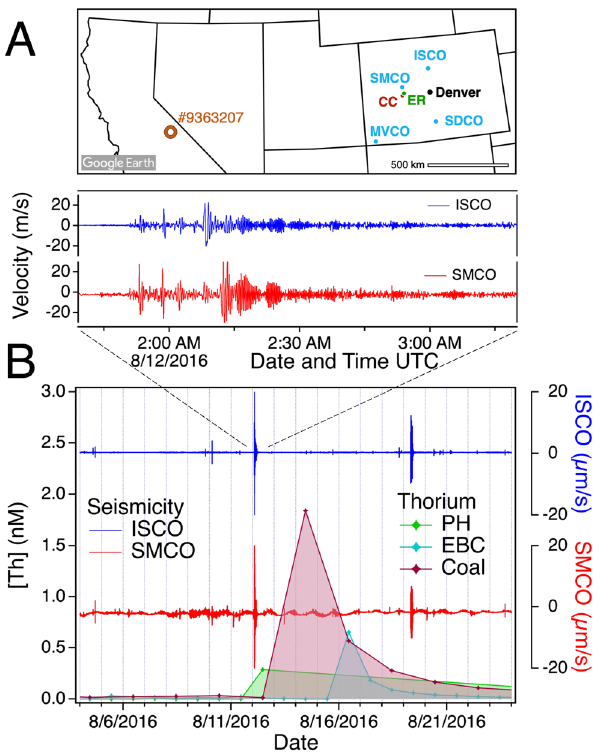
Fig. 4 | Seismicityandthoriumconcentration. A MapofthewesternUSshowing thelocationofEastRiver(ER)andCoalCreek(CC)inColorado,seismicmonitoring stations and the epicenter of seismic event #9363207. Map adapted from Google Earth. B